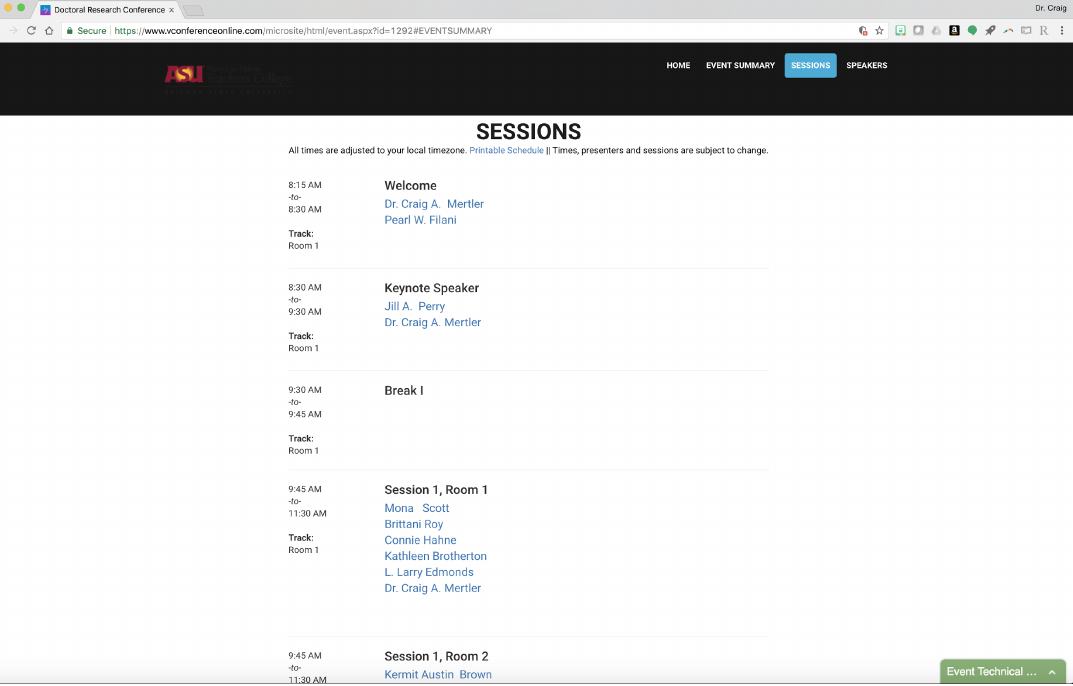
Figure 1. User interface for the Doctoral Research Conference, showing the schedule of events